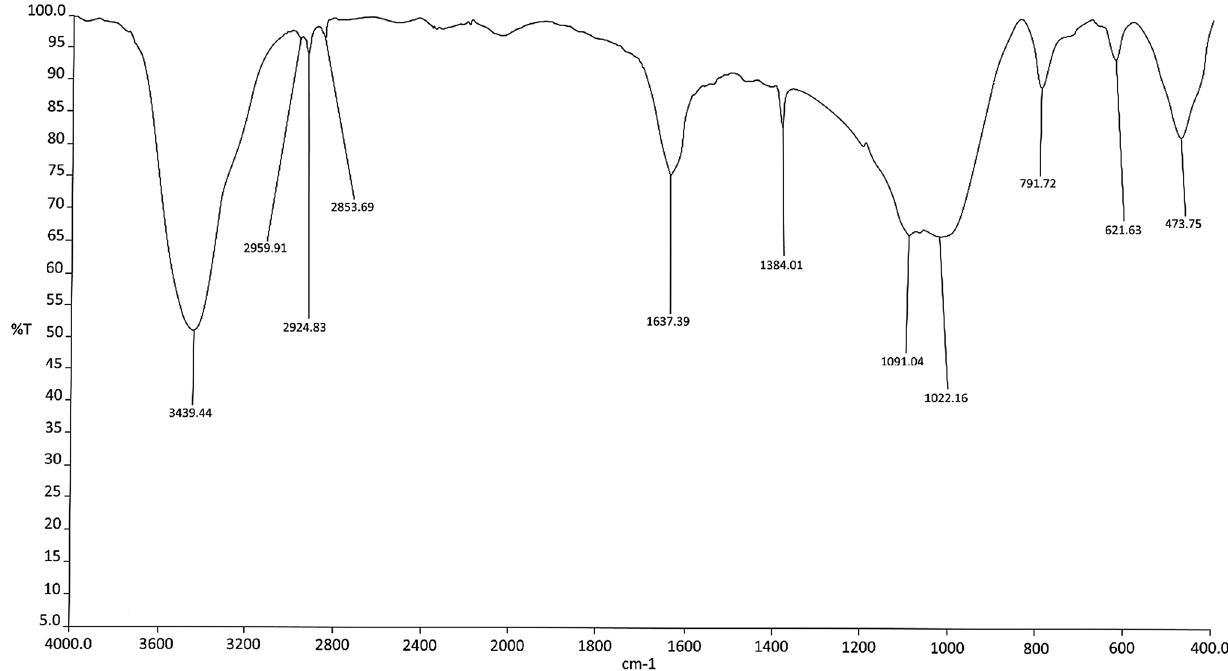
Fig. 4 FTIR absorption spectrum of MgMZBFA